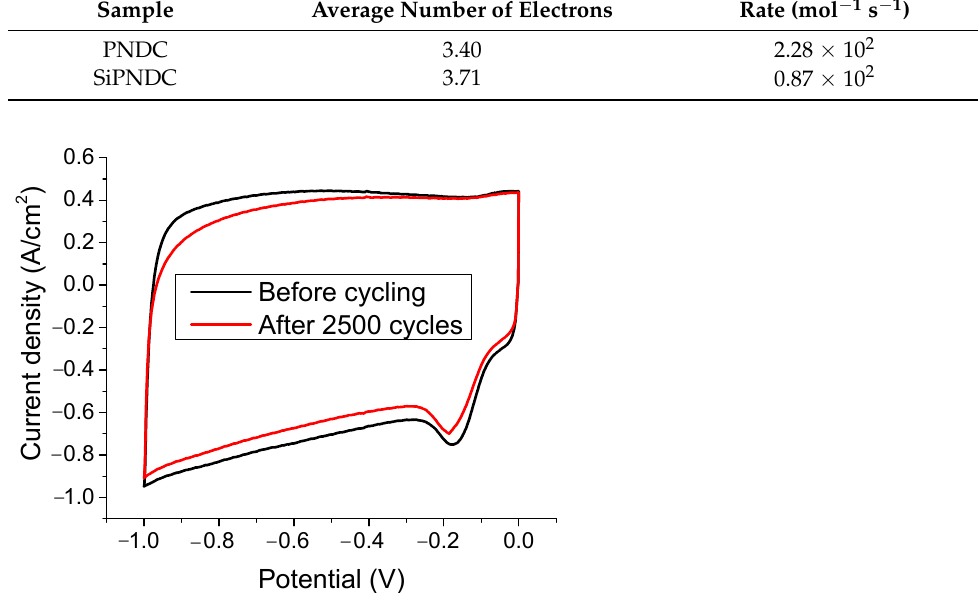
tinuous continuous cycles .